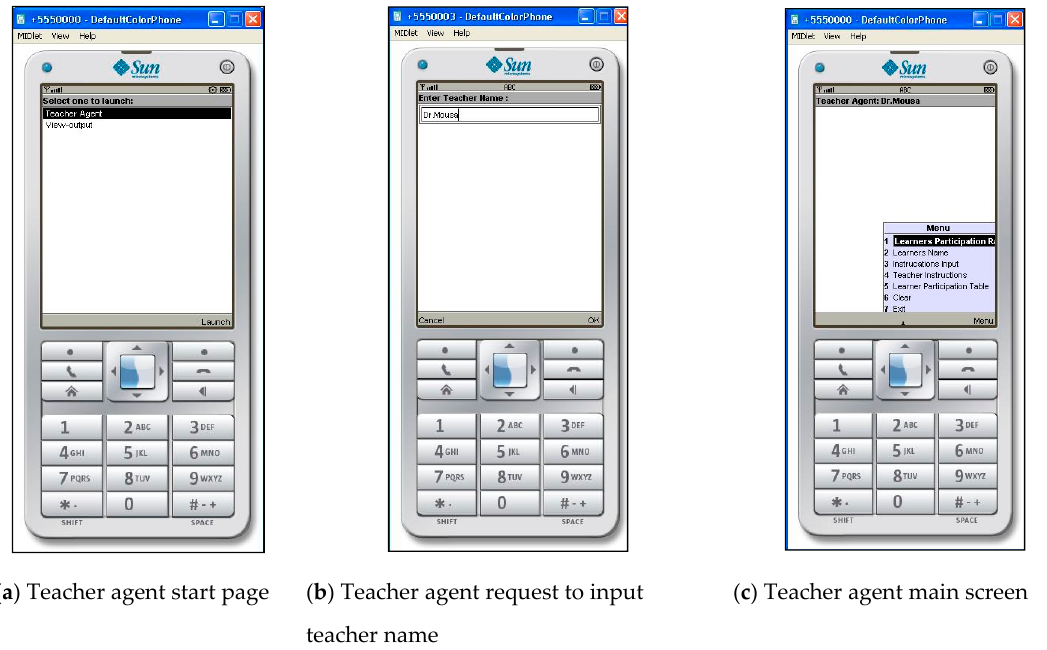
Figure 15. Mobile learning GUI — teacher agent on mobile device. Electronics 2020 , 9 , x FOR PEER REVIEW